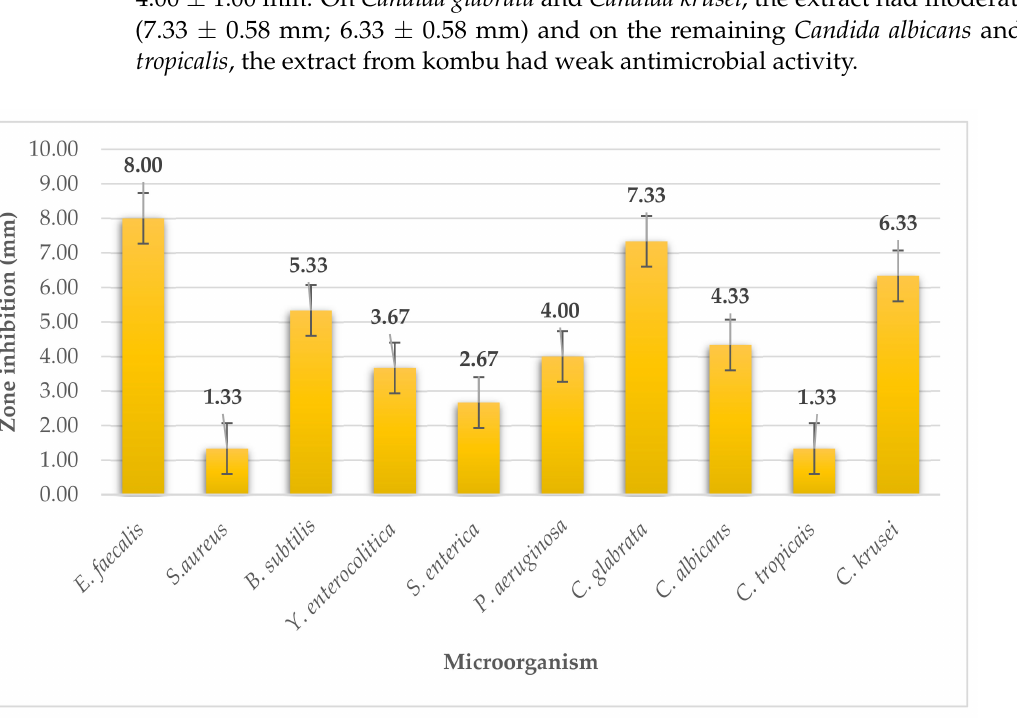
Figure 1. Antimicrobial activity of